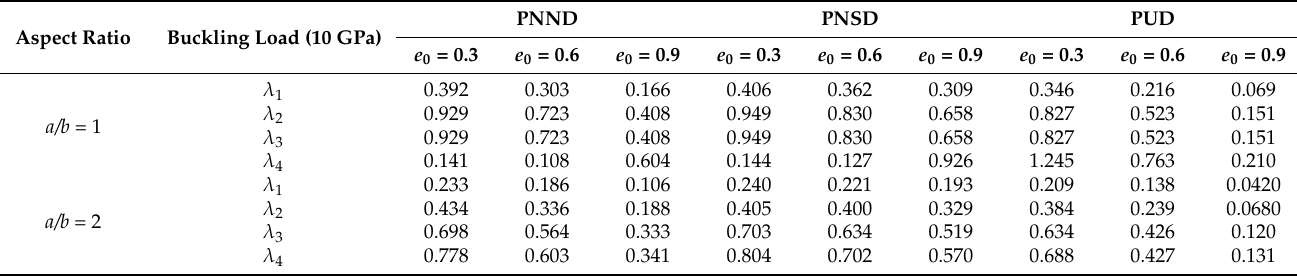
Table 6. First four uniaxial buckling loads (in the x -direction) for a SSSS FG-saturated porous plate with different aspect ratios, a / b , porosity distributions and porosity coefficients, e 0 , keeping β = 0.6 fixed. Aspect Ratio